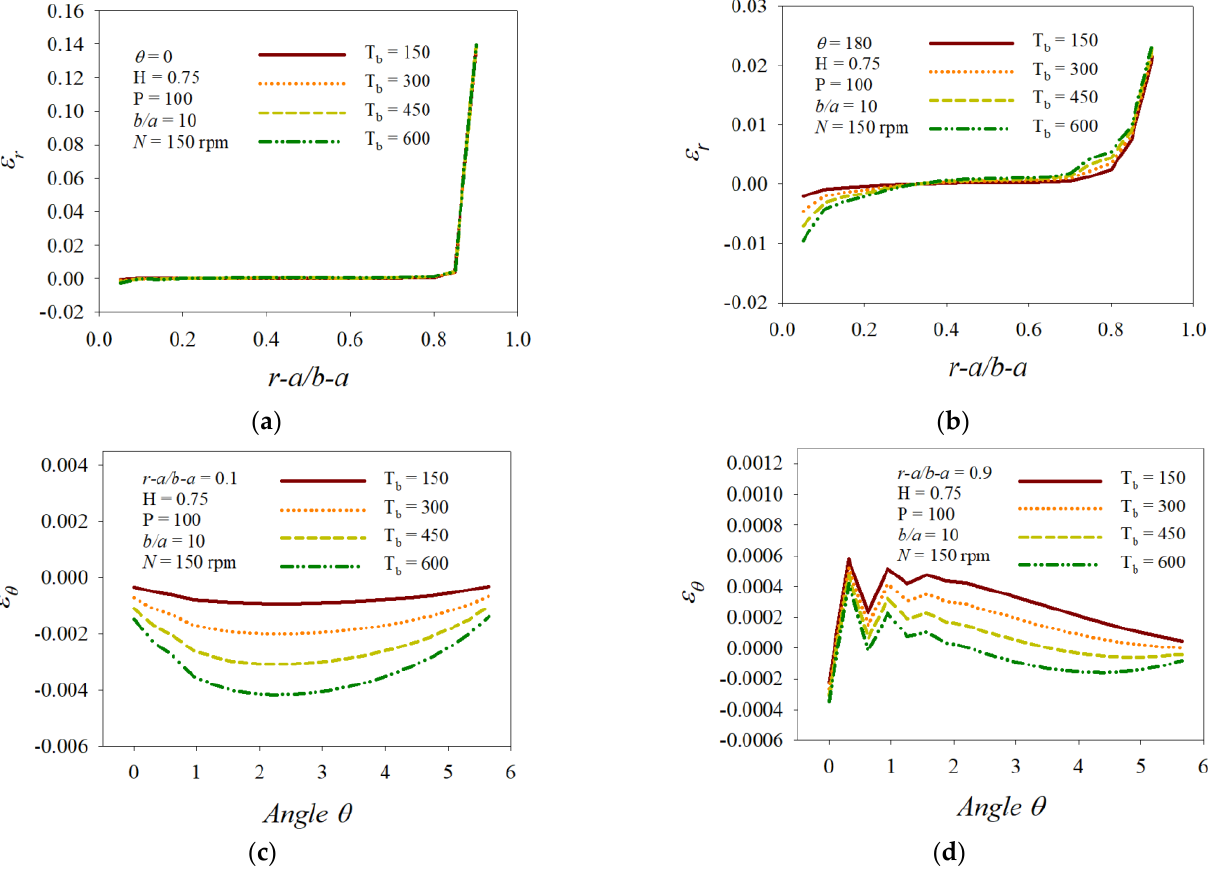
Figure 6. Effects of outer boundary temperature on the components of strain: ( a ) radial at θ = 0, ( b ) ra-